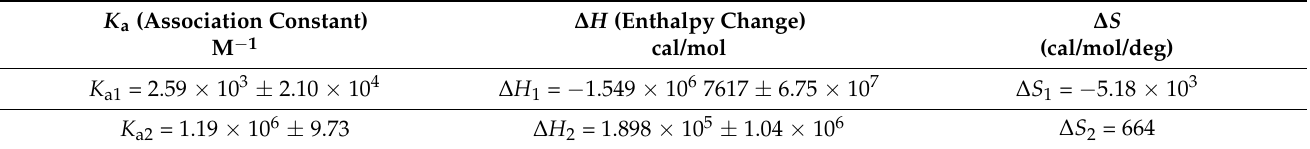
Figure 2. ( A ) ITC profile of MARK4-irisin system. The sample cell was filled with 15 µ M MARK4 while the syringe contained 200 µ M irisin. ( B ) Kinase inhibition assay of MARK4 with varying irisin concentration (0 − 15 µ M). Table 1. Thermodynamic parameters of MARK4–irisin interaction obtained from ITC. K a (Association Constant) M −